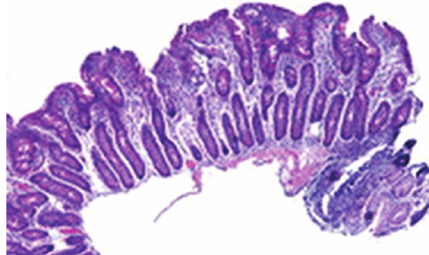
Figure 2: Villous atrophy grade 3c according to Marsh’s classifica- tion.